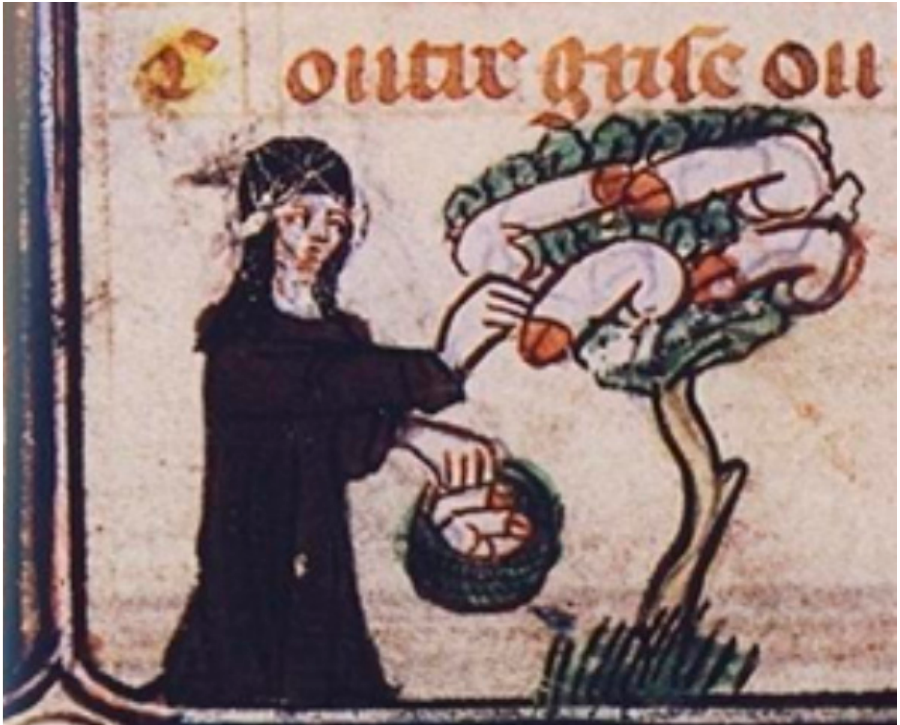
Figure 17. Nun at Phallus tree. BNF fr. 25526, 106v.